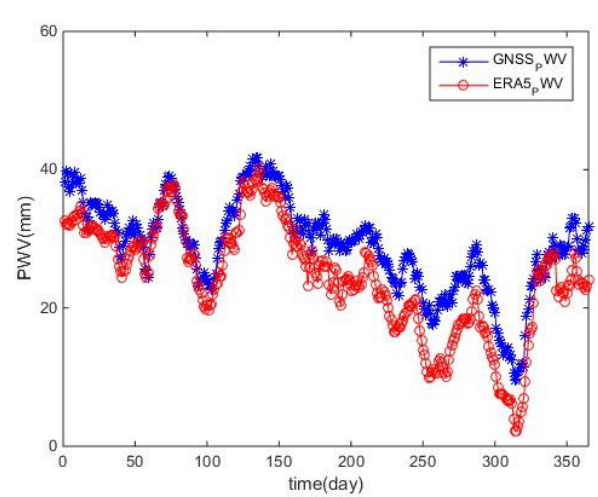
Figure 3. HKPC PWV